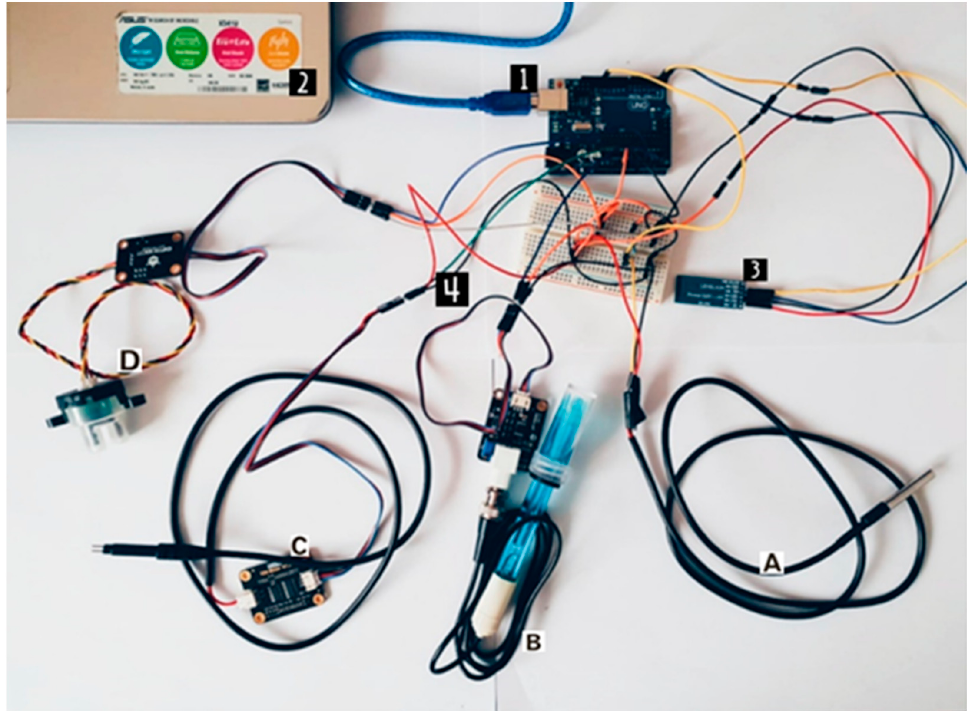
Figure 4. Setup of the Arduino-based sensor system. Table 2. Components prices for a low-cost system approach.